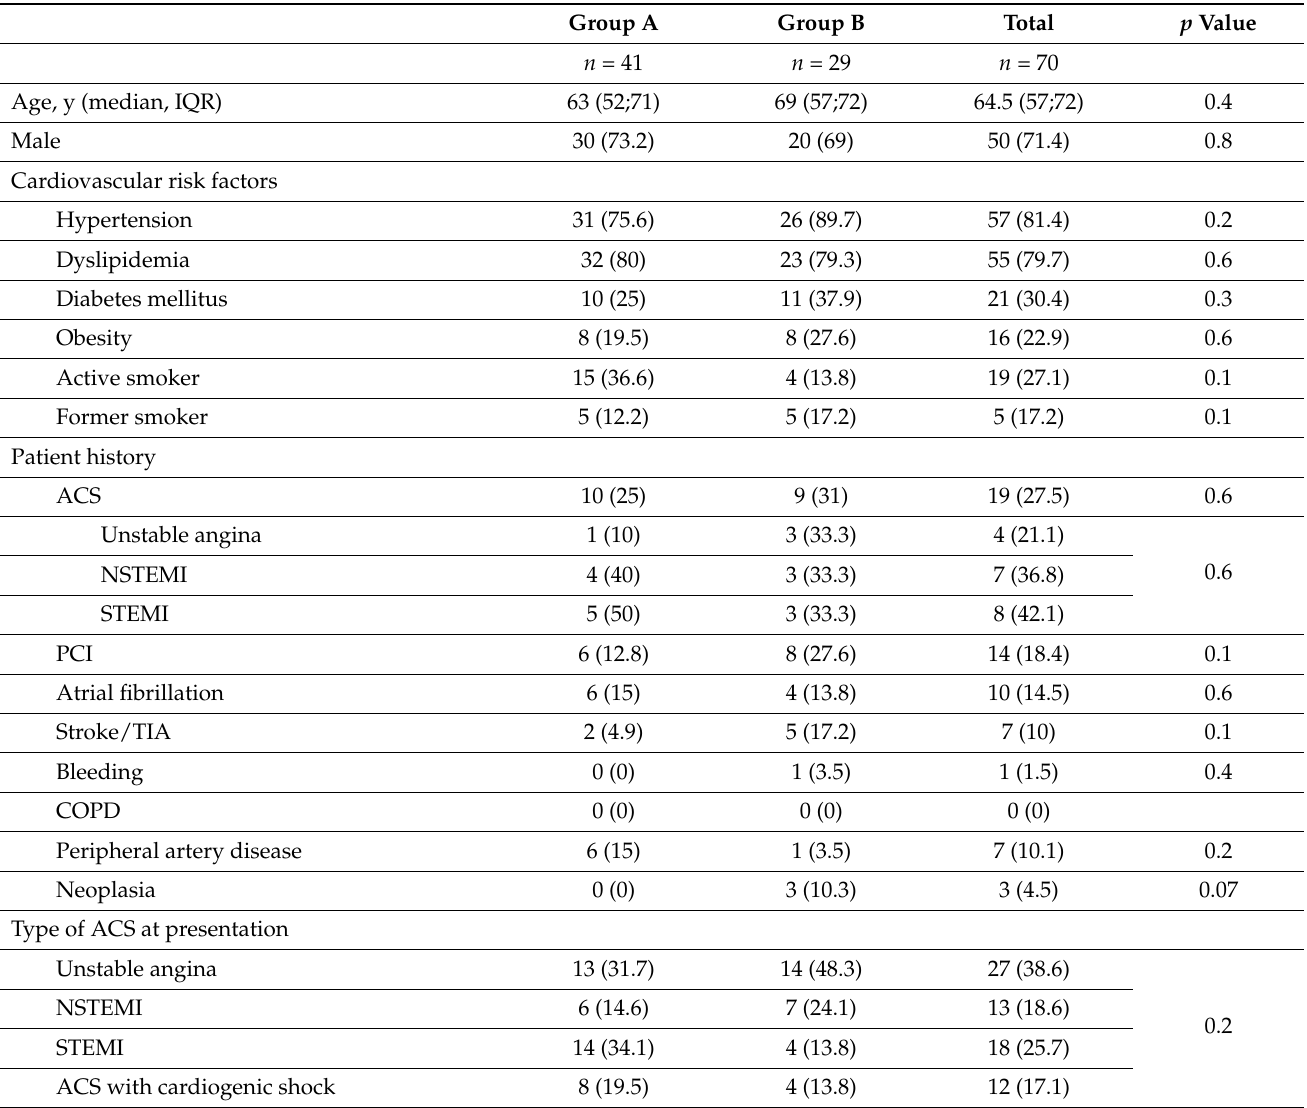
Table 1. Demographic and baseline clinical characteristics according to the stent strategy in patients with unprotected left main coronary artery disease and acute coronary syndrome (Group A—one stent strategy; Group B—two stent